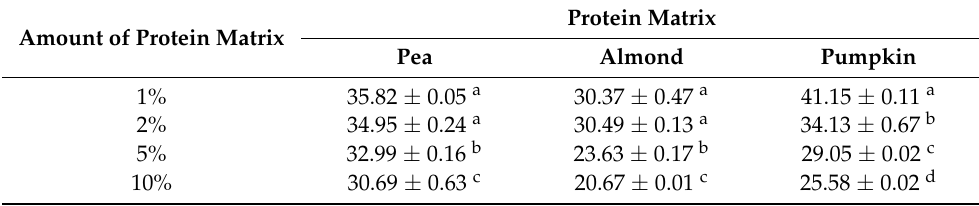
Table 1. Amounts of cinnamic acid (mg/g) on protein complexes. Amount of Protein